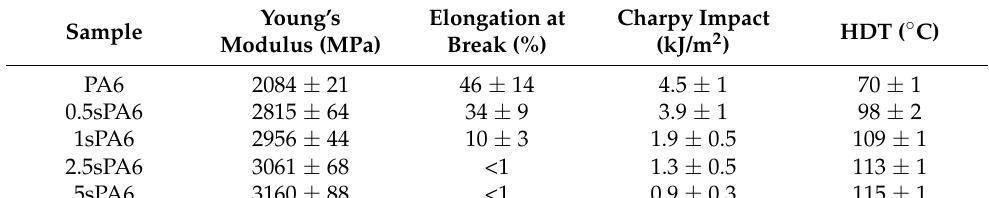
Table 2. Mechanical properties of raw polyamide and star-branched polyamides. Sample